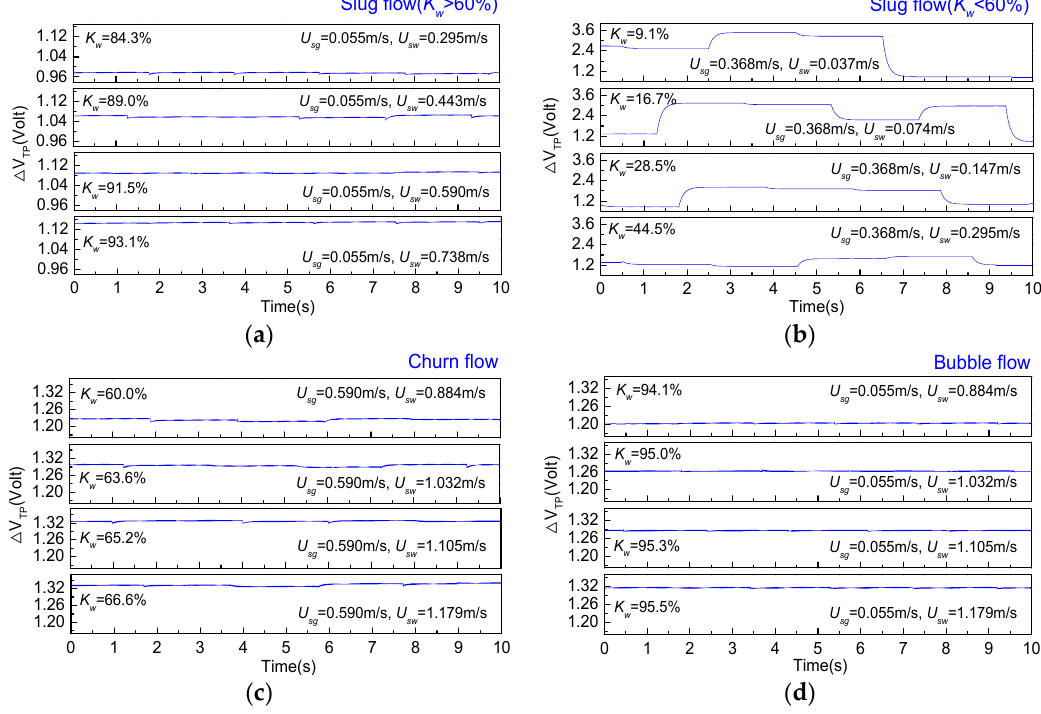
Figure 3. Output signals of the EMF for gas–water two-phase flows. ( a ) slug flow ( K w > 60%); ( b ) slug flow ( K w < 60%); ( c ) churn flow; ( d ) bubble flow.